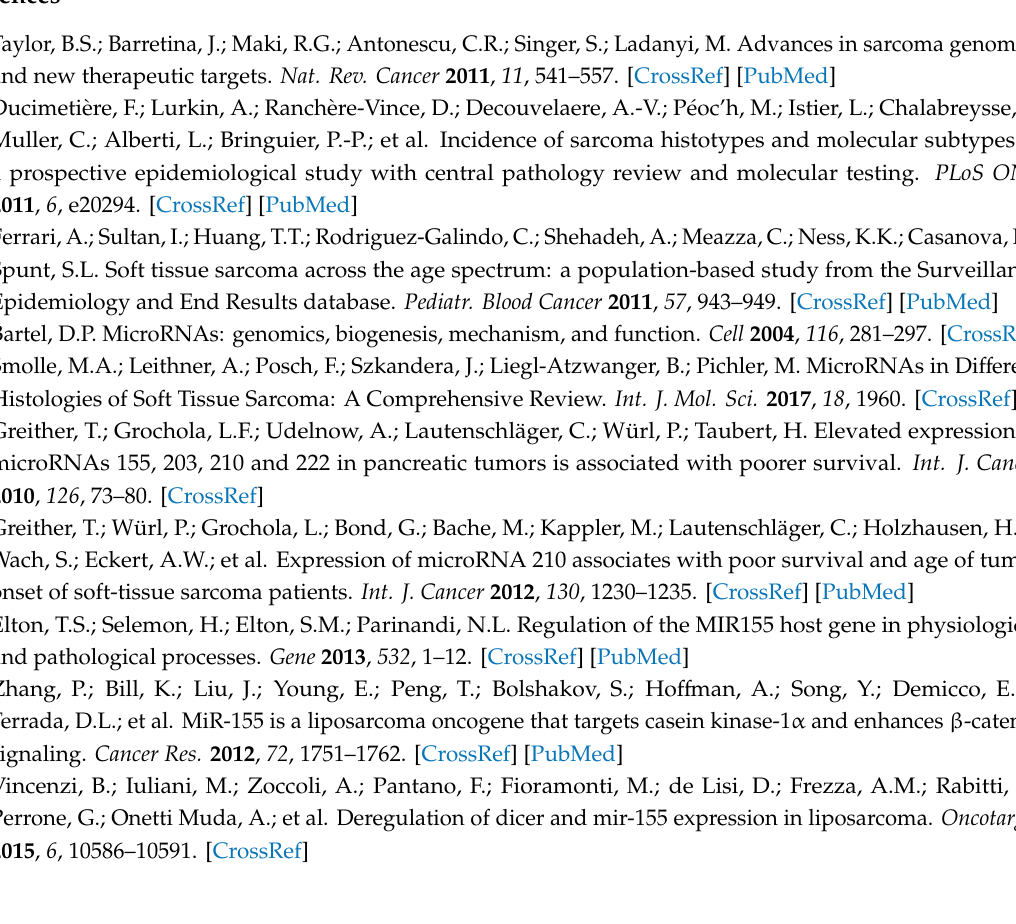
Figure S1: The distribution of miR-155 expression and miR-203 in relation to the histological subtype, Table S1: Univariate and multivariate Cox regression survival analyses of the impact of miR-155 and miR-203 on soft tissue sarcoma patient survival in di ff erent histological